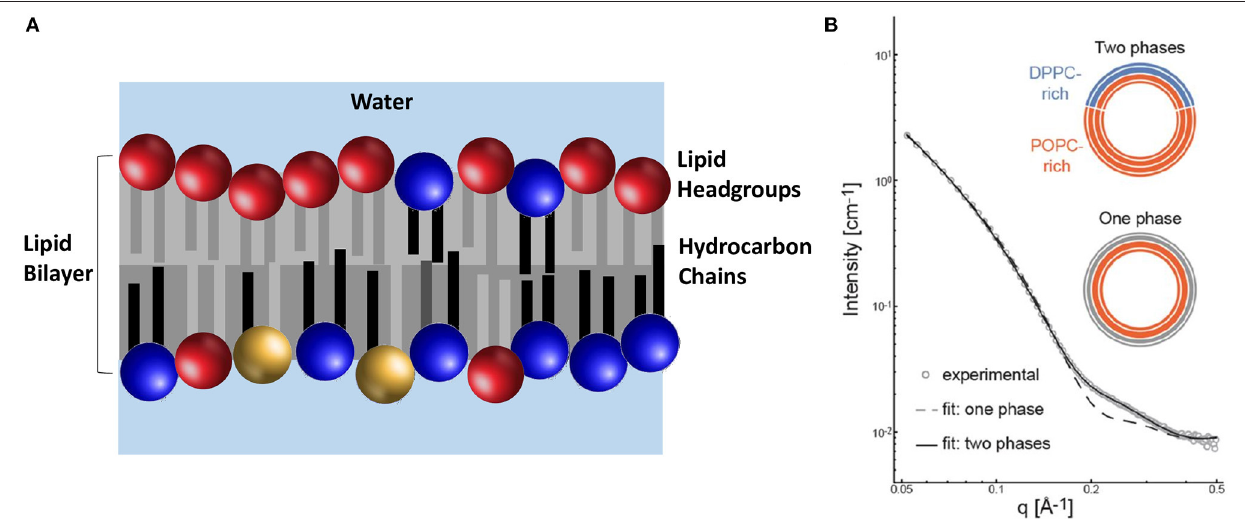
FIGURE 4 | The lipid composition of the PM is asymmetric with regard to the location of its chemically different lipid molecules. (A) The outer (upper) leaflet contains different lipid headgroups (primarily PC headgroups lipids shown in red) in relation to the inner (lower) leaflet (primarily blue and yellow depicting PE and PS headgroups, respectively). Additionally, the composition of the acyl chains between the two leaflets is also different. The outer leaflet has lipids with mostly saturated acyl chains (gray), whereas the inner leaflet lipids have acyl chains with different levels of unsaturation (black and light gray). (B) SANS data of aULVs where the outer leaflet contains 34 mol% of a rigid saturated lipid (DPPC) and the inner leaflet contains 98 mol% of a fluid state unsaturated lipid (POPC). The best fit to the data was obtained using a model that took in to account the presence of two lipid phases in the outer leaflet. Importantly, DPPC was found to be more fluid, compared to a pure DPPC bilayer, suggesting an interaction between the two bilayer leaflets. Adapted from Heberle et al.